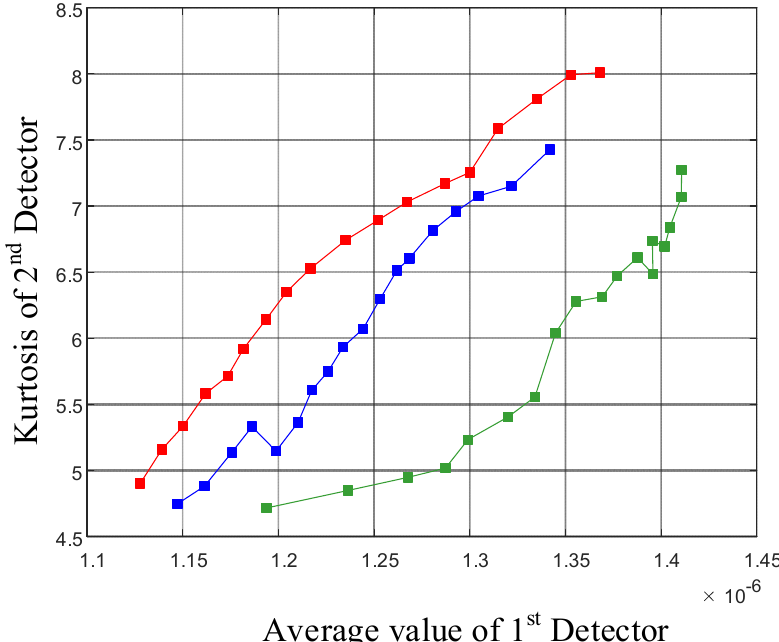
Figure 6. One of the features with separated graphs.